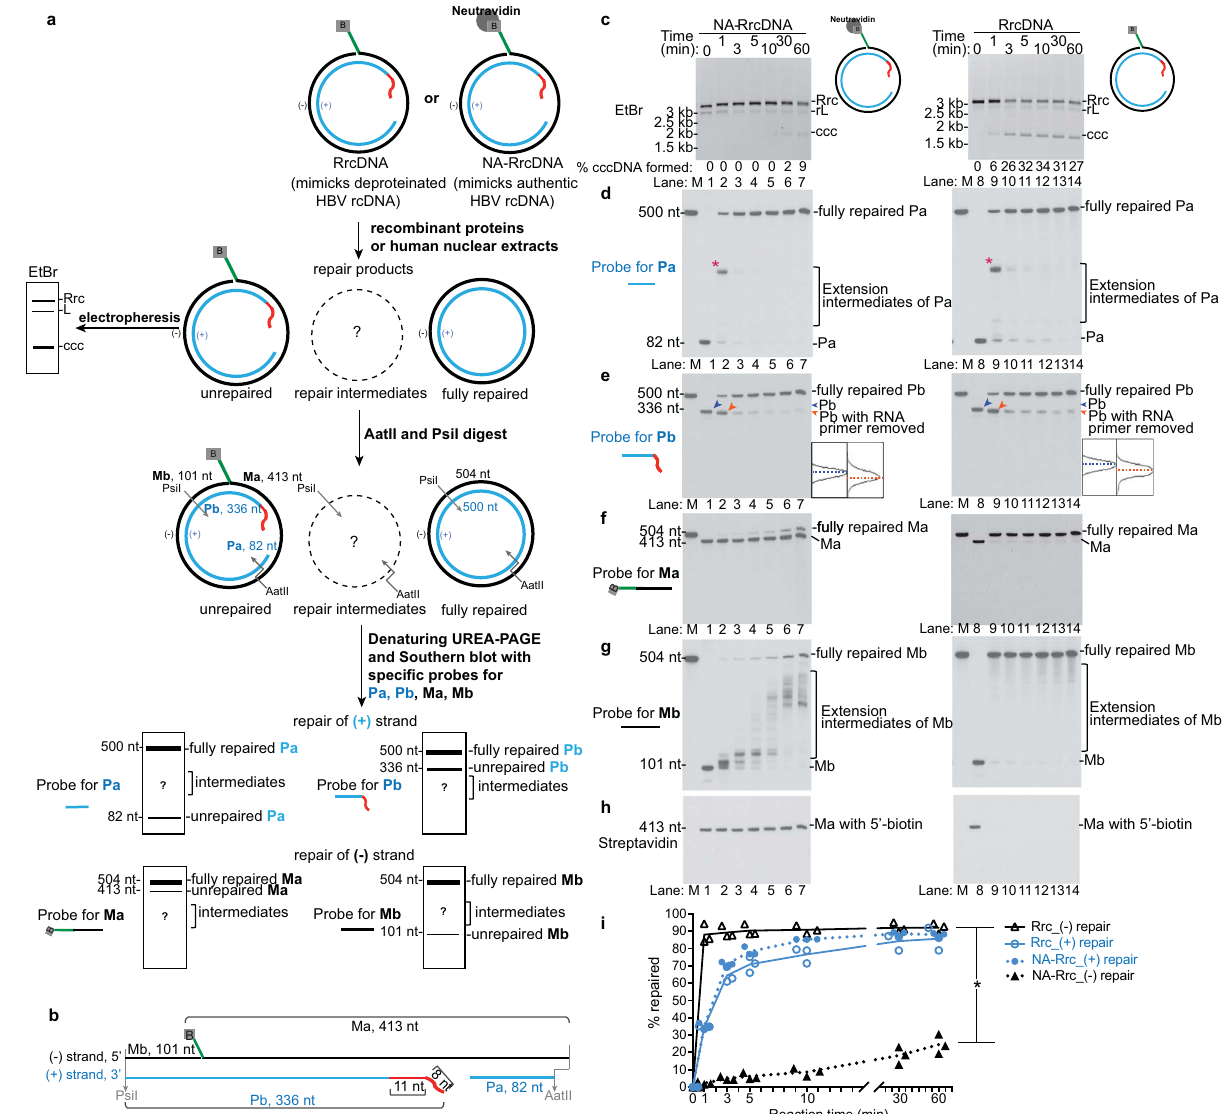
Fig. 2 Repair of lesions on HBV rcDNA plus- and minus-strands with puri fi ed human factors. a Schematic of examining the kinetics of repair on plus- and minus-strands simultaneously by Southern blot. One half of the repair products were used to monitor cccDNA formation by agarose gel electrophoresis; the other half was digested to generate four fragments of interest: Pa and Pb containing lesions on the plus-strand; Ma and Mb harboring lesions on the minus-strand. These four fragments of repair intermediates (denoted by “ ? ” ) could be detected by Southern blot as illustrated by idealized blots. The location of the repair intermediates are arbitrarily chosen and indicated by “ ? ” . Green line, biotinylated fl ap; B, biotin; red line, RNA primer. b Schematic depicting the four fragments in digested unrepaired RrcDNA. c A time course cccDNA formation assay with NeutrAvidin-RrcDNA (NA-RrcDNA, lanes 1 – 7) or RrcDNA (lanes 8 – 14) and fi ve puri fi ed factors, as depicted in a . “ % cccDNA formed ” was calculated as described in Fig. 1e, f. d The repair of the plus- strand Pa fragment is monitored by Southern blot. “ * ” indicates extension products of Pa that reach the 5 ′ terminus of Pb. e The repair of plus-strand RNA primer-containing Pb fragment is monitored by Southern blot. Traces (plotted with gel-pro fi le function in ImageJ) denote unprocessed (blue arrow head) and processed product (orange arrow head) of Pb fragments, respectively, at 1 min. f – g Repair of minus-strand Ma and Mb fragments are monitored by Southern blot. h Removal of biotin-containing fl ap in Ma is detected by Streptavidin blot. i The repair ef fi ciency of plus- and minus-strands is calculated from e and f and plotted. “ % repaired ” is calculated by dividing the band intensities of fully repaired Pa or Ma by the sum of the band intensities of unrepaired, intermediate, and fully repaired Pa or Ma. M, marker; Rrc , RrcDNA; rL, recombinant linear RrcDNA; ccc, cccDNA. All experiments were repeated three times. The lines connect the average value of three measurements at each time point. P values are 0.00001, 0.000002, 0.000003, 0.000002, 0.00002, and 0.00005 at time points between 1 and 60 min. Source data are provided as a Source Data fi 5d). Similar results were also observed when RFC-PCNA-POL δ was added before FEN-1 (Supplementary Fig. 5a; 5b – c, lanes 2, 4, 5, 7, 8, 10; and 5d). These results indicate that the sequential addition of these factors led to defective generation of LIG1- ligatable ends in the plus strand, suggesting that these factors function in a concerted fashion in repairing the plus strand.